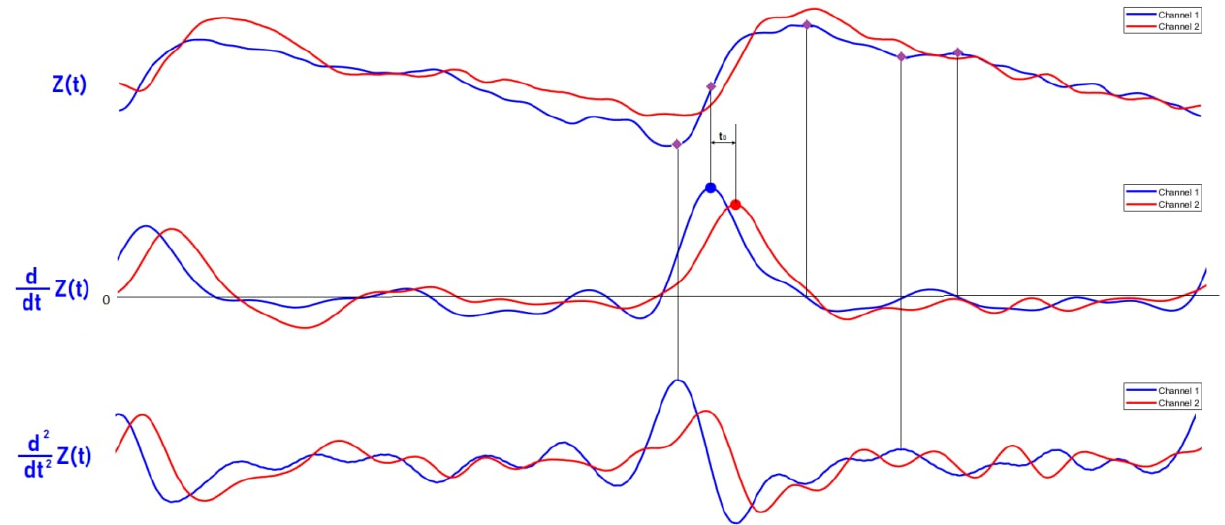
Figure 9. The recording of the bio ‐ impedance signal with the first and second